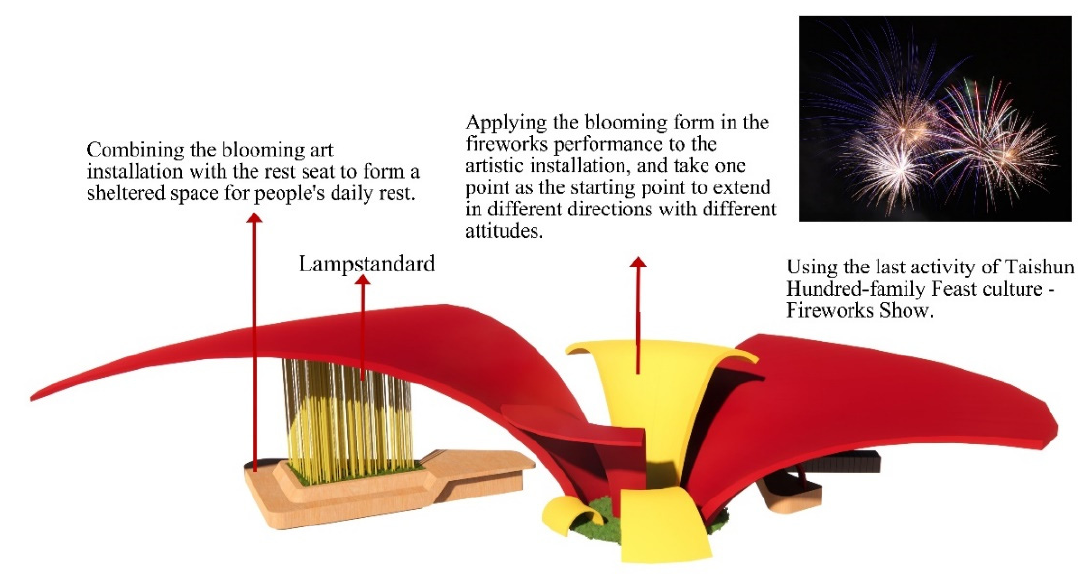
Figure 23. Blooming art installation.